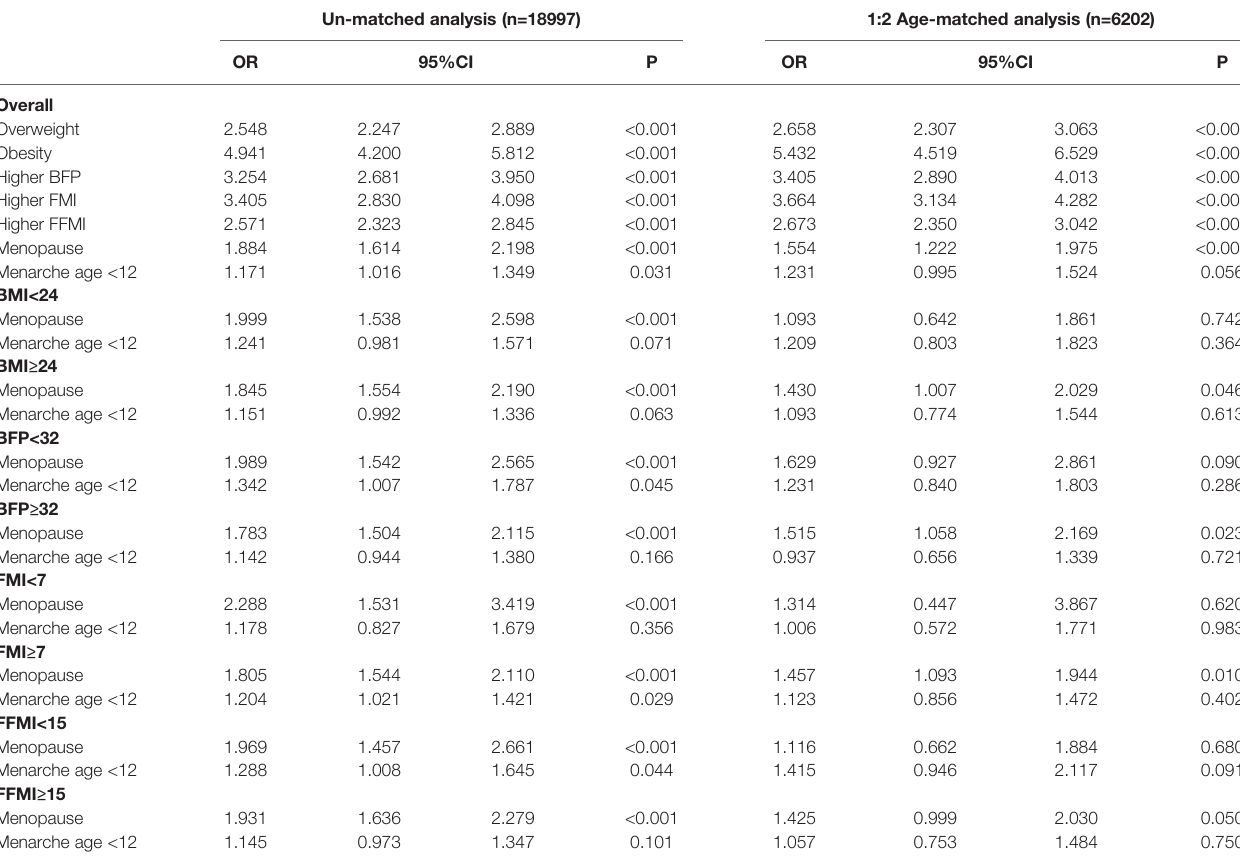
TABLE 3 | The results of logistic regression modeling examine the effect of reproductive and body composition factors on hyperuricemia. Un-matched analysis